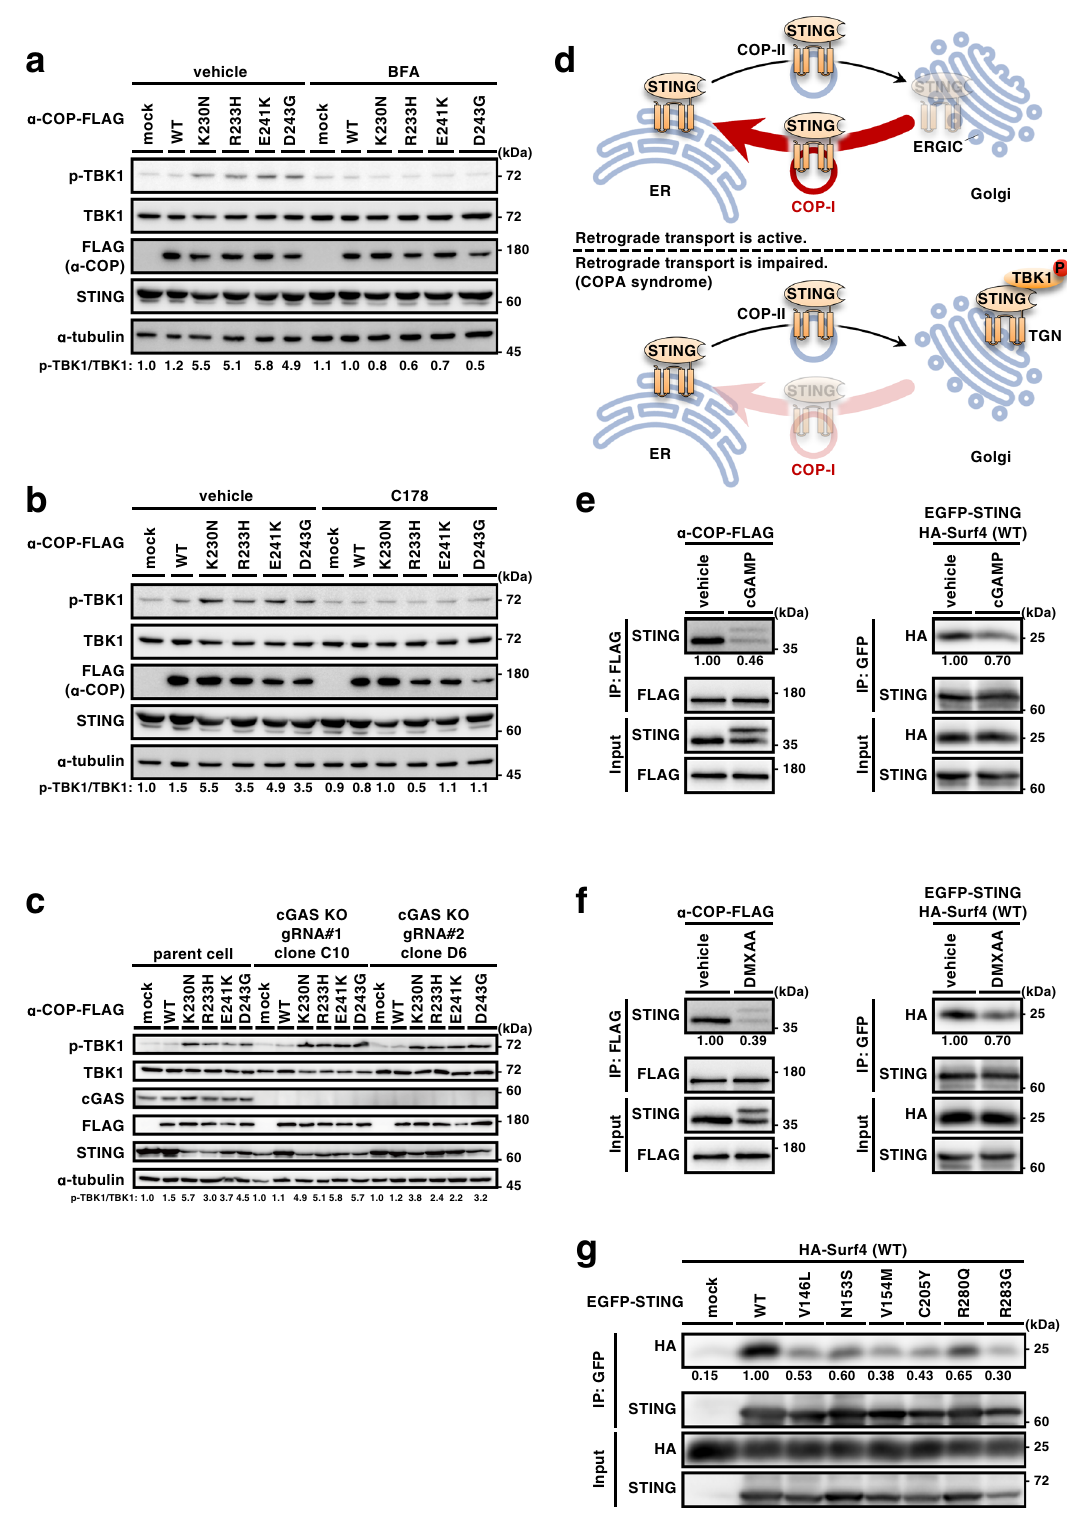
Fig. 4 STING activation with the α -COP variants requires the ER-to-Golgi traf fi c and palmitoylation of STING, but not cGAS. a , b MEFs expressing various α -COP as indicated were treated with BFA (0.3 µ g/ml) for 8 h ( a ) or with C178 (10 µ M) for 8 h ( b ). Cell lysates were prepared and analyzed by western blot. c α -COP was stably expressed in cGAS-KO MEFs. Cell lysates were prepared and analyzed by western blot. d A model of STING regulation by membrane traf fi c between the ER and the Golgi. e , f α -COP-FLAG was stably expressed WT MEFs, or HA-Surf4 was stably expressed in Sting -/- MEFs that were reconstituted of EGFP-STING. Cells were stimulated with cGAMP ( e ) or DMXAA ( f ) for 1 h. Cell lysates were prepared, and α -COP-FLAG or EGFP- STING was immunoprecipitated. Cell lysates and the immunoprecipitates were analyzed by western blot. g HEK293T cells were transfected with the indicated plasmids. Cell lysates were prepared and EGFP-STING were immunoprecipitated. Cell lysates and the immunoprecipitates were analyzed by western